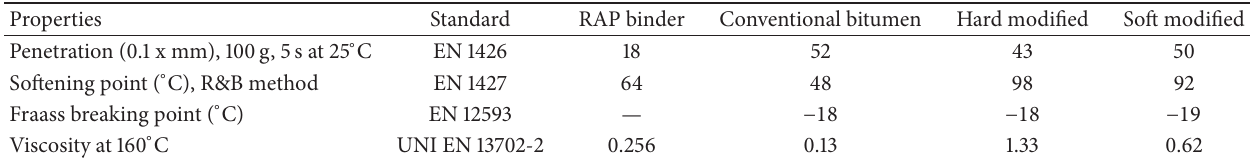
Table 2: Bitumen characterization.